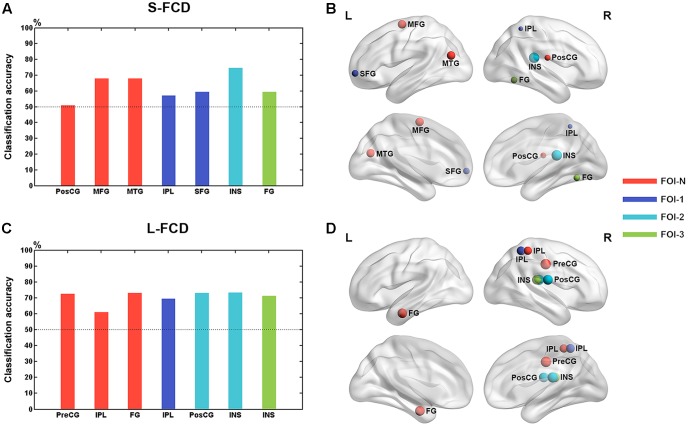
Classification performance of each between-group difference region. The classification accuracy of each between-group difference region in S-FCD (A) and L-FCD (C). Rendering plot of the between-group difference regions in S-FCD (B) and L-FCD (D) used in the classification. Colors assigned in the sequence of red, blue, cyan, and green represent the frequency bands such as FOI-N, FOI-1, FOI-2, and FOI-3, respectively. The size of the node in (A,B) represents the accuracy of the normalized region classification performance. The left hemisphere is on the left.